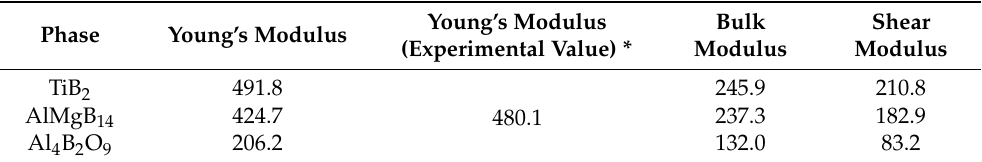
Table 4. Elastic moduli (GPa) of the main phases of the obtained material.